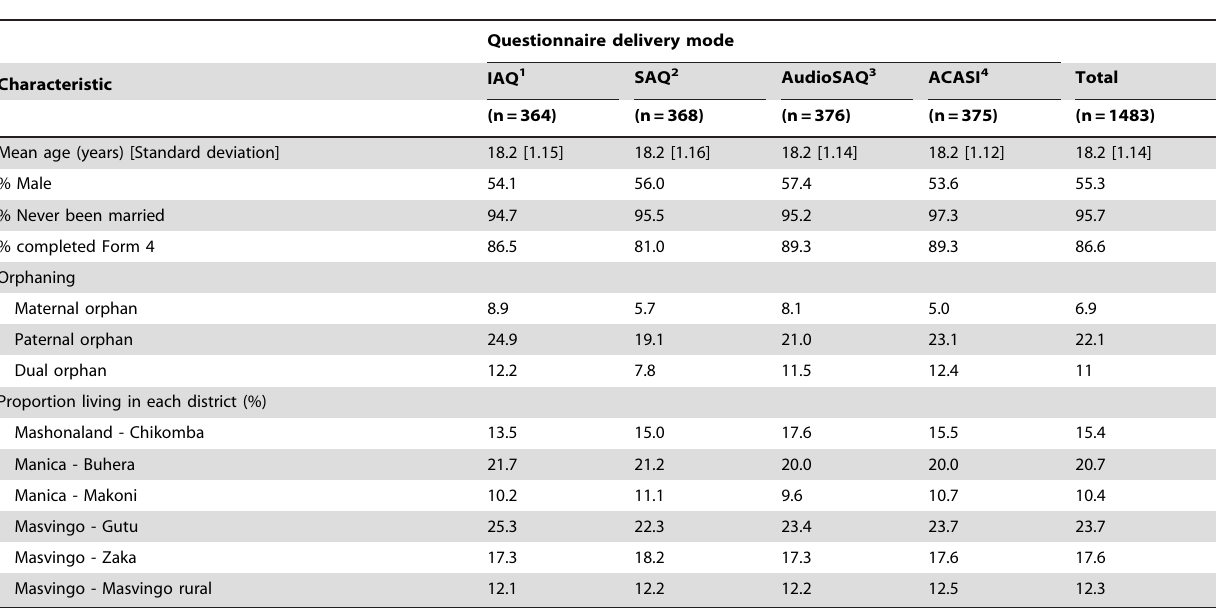
Table 1. Demographic characteristics by questionnaire delivery